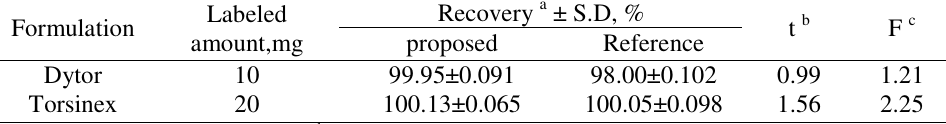
Table 3 . Results of analysis of tablet formulations containing